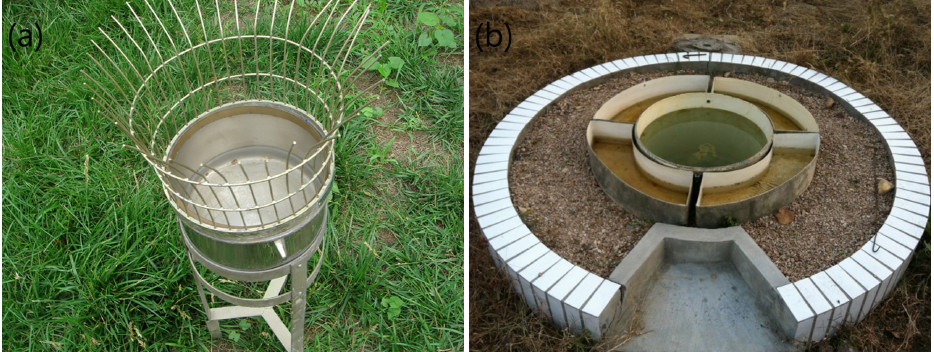
Figure 1. Two types of evaporation pans: 20 cm diameter evaporation pan ( a ); E601 evaporation pan ( b ). Table 1. Detailed information on the two types of evaporation pans. Name of